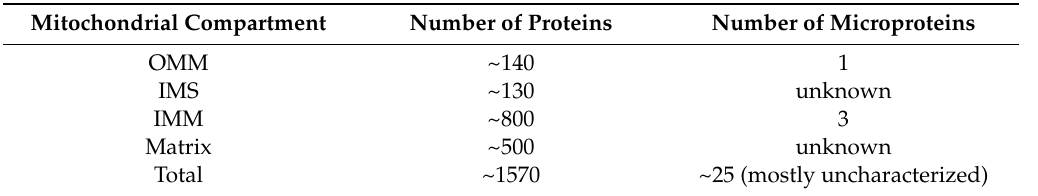
Table 1. Compartmentalization of mitochondrial proteome, with the number of proteins and microproteins present in di ff erent mitochondrial compartments. OMM, outer mitochondrial membrane; IMM, inner mitochondrial membrane (IMM); IMS, intermembrane